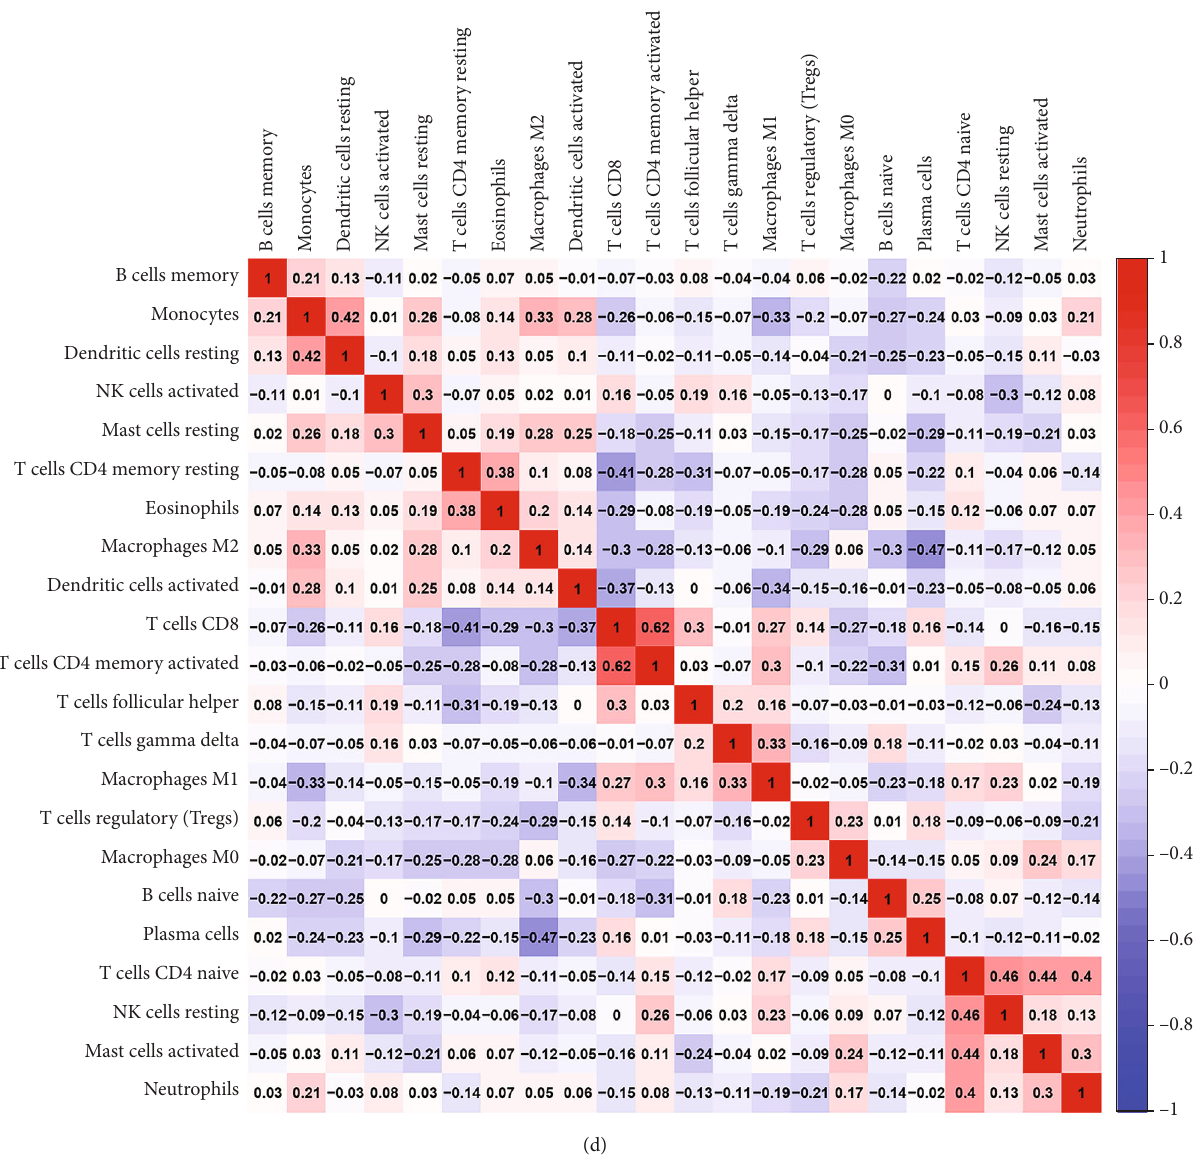
Figure 5: Evaluation of immune cell abundance in di ff erent clusters of LUAD samples by CIBERSOFT algorithm. (a) Cluster 1. (b) Cluster 2. Di ff erent colors represent di ff erent immune cell in fi ltration. (c) Correlation analysis of immune cell abundance in cluster 1. (d) Correlation analysis of immune cell abundance in cluster